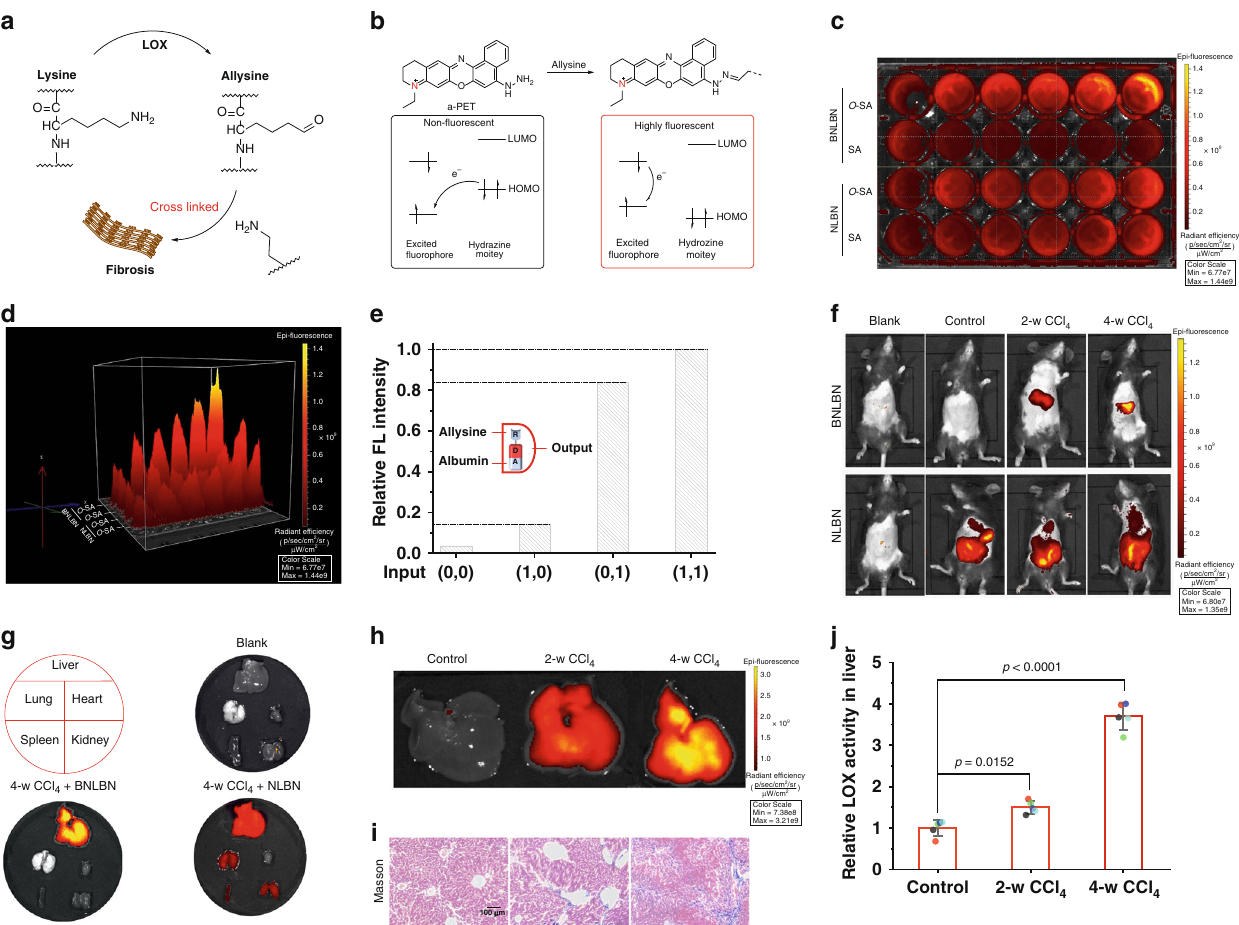
Fig. 4 Evaluation of the devised “ pocket-escaping ” probe for in vivo imaging of liver fi brosis in mice. a The illustration of fi brosis mediated by allysine. b The mechanism of developing probe for allysine. c , d Fluorescence photograph and quanti fi cation analysis of BNLBN and NLBN (10 µ M for each) in imaging O -SA (0 − 10 µ M). e Molecular logic gates for illustrating the backdoor problem of NLBN on the detection. f In vivo tracing liver fi brosis by BNLBN and NLBN (100 μ L, 200 μ M, intravenously for each of these two probes). g Tissue fl uorescence images with BNLBN and NLBN in liver, lung, heart, spleen, and kidney. h Fluorescence imaging of liver in different model by BNLBN. i Masson staining of liver tissues from mice. Scale bar = 100 µ m. j LOX activity assay of CCl 4 -induced liver fi brosis model. Data are represented as mean values± SD ( n = 5 mice for each group). Statistical signi fi cance was determined by one-way ANOVA with Tukey ’ s test. p = 0.0152 for 2-w CCl 4 treated group versus the control group. p < 0.0001 for 4-w CCl 4 treated group versus the control group. blank: without any treatment; control: treated with PBS; mild fi brosis: twice a week, intraperitoneal injection of CCl 4 (10% in olive oil; 1 mL/kg, for 2 weeks); severe fi brosis: the same treatment as but for 4 weeks. Source data for Fig. 4j are provided as a Source Data fi liver-related cell types, stellate cell line HSC-T6 and hepatocytes cell line AML 12 (Supplementary Fig. 15). Then, we evaluated the in vivo ef fi cacy of BNLBN for detecting fi brogenesis in a murine model of liver fi brosis induced by carbon tetrachloride (CCl 4 ) 40,41 . The mice were divided into four groups — (i) blank: without any treatment; (ii) control: treated with PBS; (iii) mild fi brosis: twice a week, intraperitoneal injection of CCl 4 (for 2 weeks); (iv) severe fi brosis: the same treatment as (iii) but for 4 weeks. Then, the